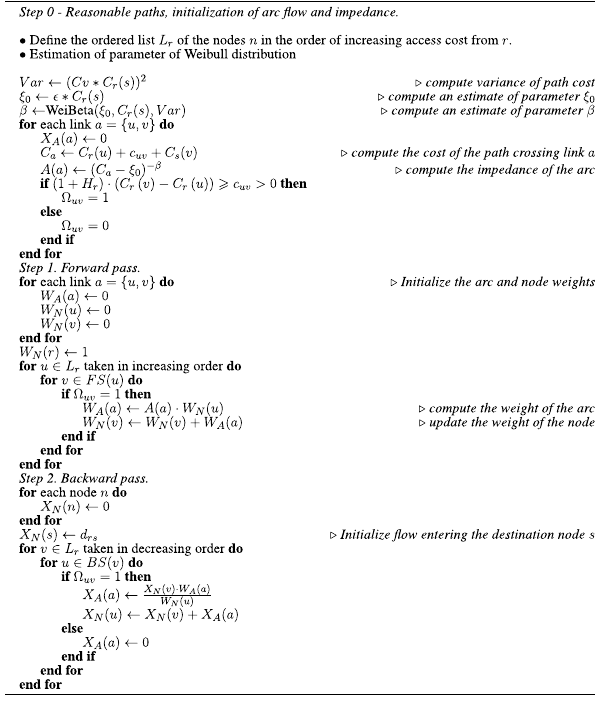
Algorithm 2. Implicit weibit loading